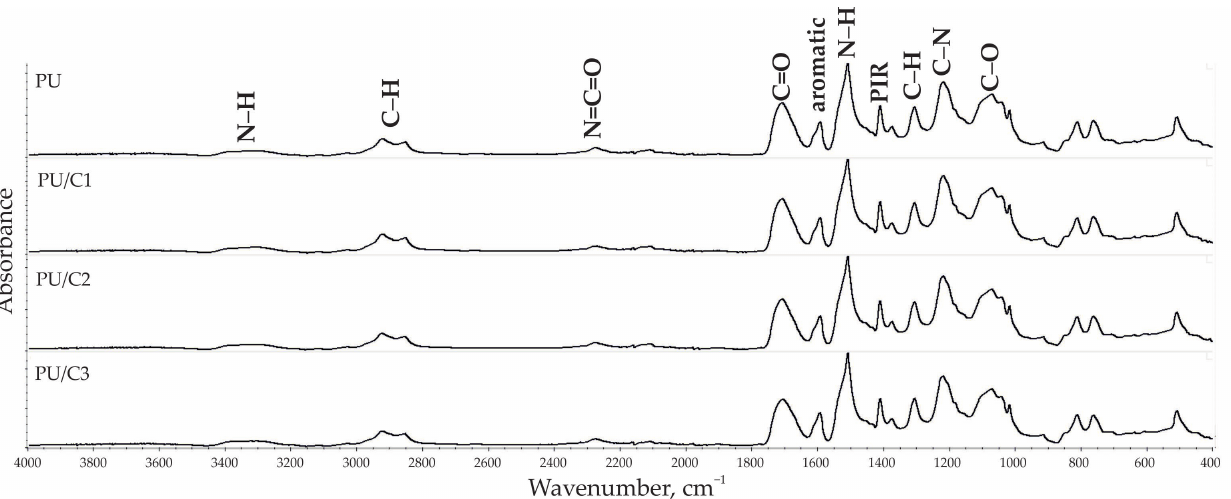
Figure 7. SEM images of PU, PU/C1, PU/C2, and PU/C3 ; magnification: ×40.